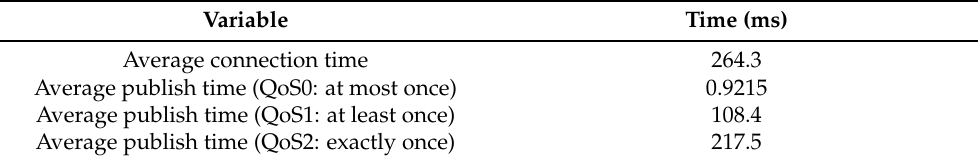
Table 2. Time required for an MQTT-IoT message transmission.